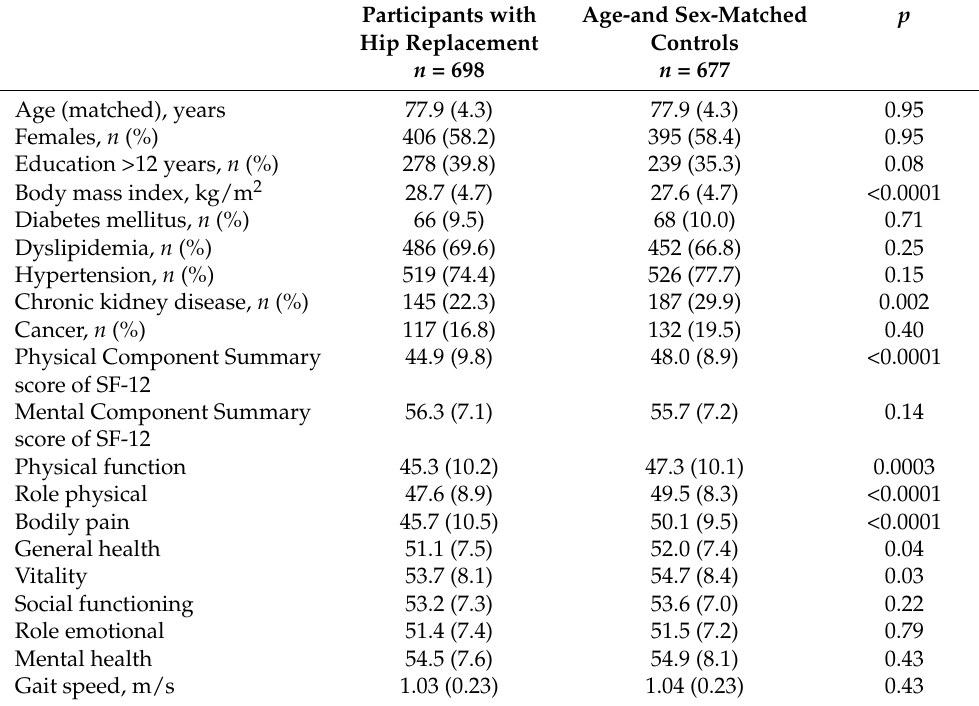
Table 1. Characteristics of participants with hip replacement and age- and sex-matched controls at ASPREE